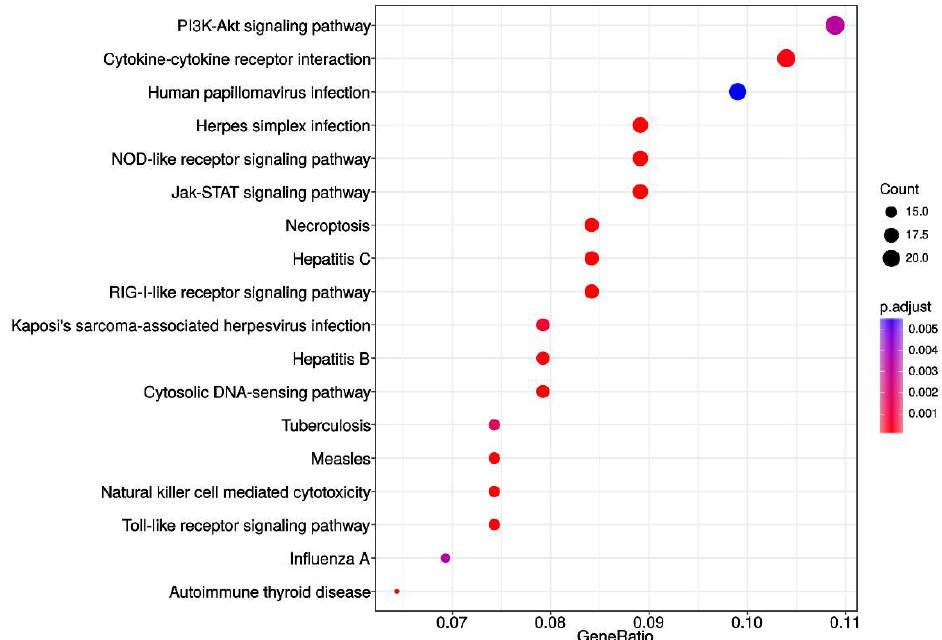
Figure 4. Enrichment analysis utilizing the KEGG pathway database. Analysis included genes from all malignant samples associated with both deleted and amplified regions. No significant enrichment was associated with amplified segments.